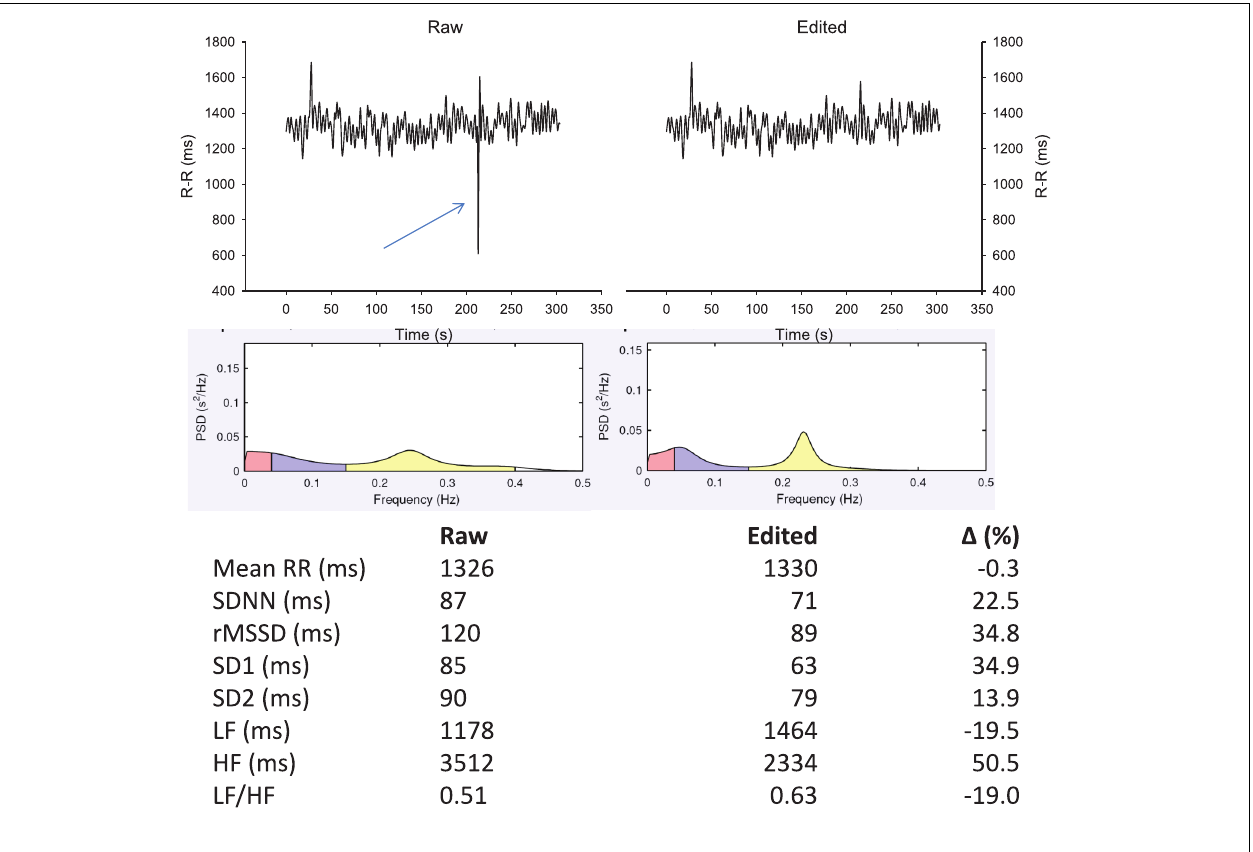
two R-R series. SDNN, standard deviation of normal R-R intervals; rMSSD, square root of the mean of the sum of the squares of differences between adjacent normal R-R intervals; SD1, standard deviation of instantaneous beat-to-beat R-R interval variability measured from Poincaré plots; SD2, standard deviation of long-term beat-to-beat R-R interval variability measured from Poincaré plots; LF, low-frequency oscillations, HF, high-frequency